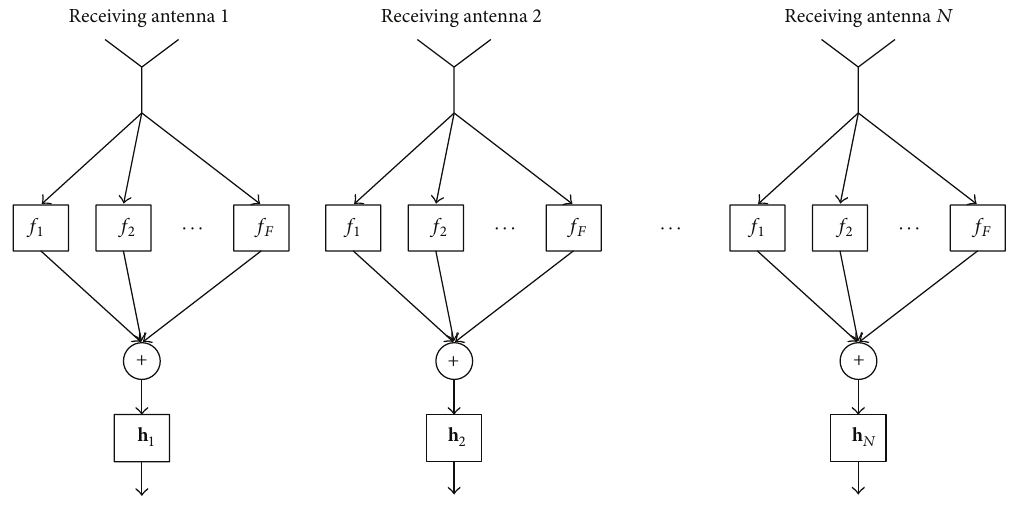
Figure 2: The structure of receive